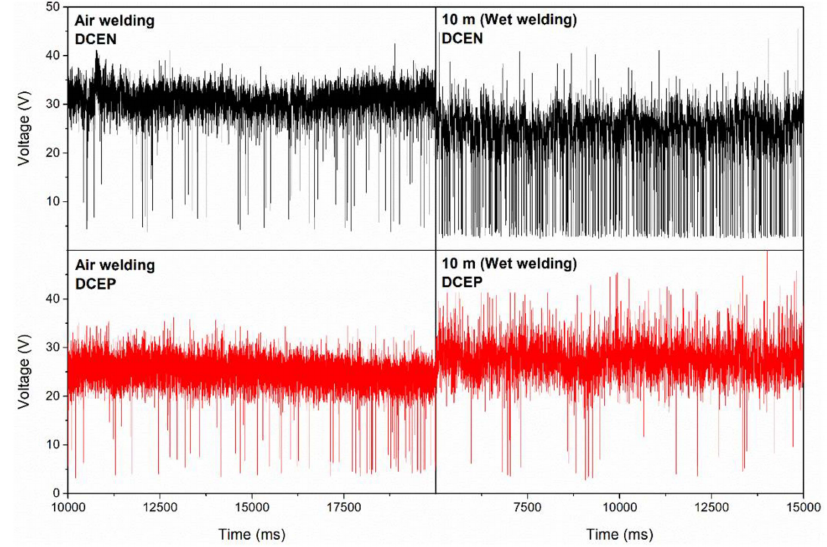
Figure 5. Welding voltage oscillograms for tests carried out in the air and at a depth of 10 m with a rutile electrode and for both polarities.